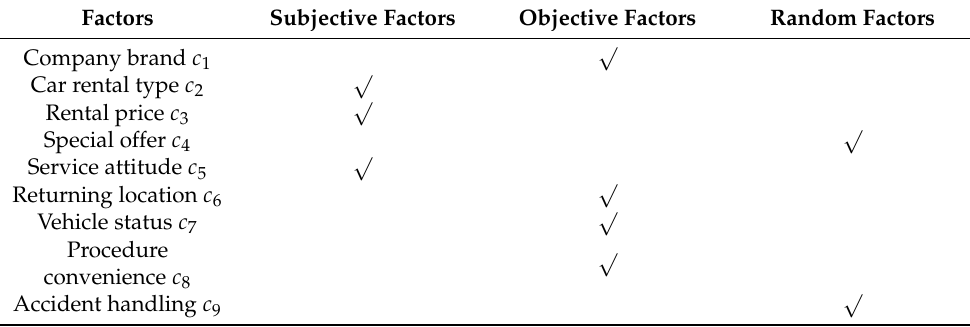
Table 1. Factors affecting customer car rental choice